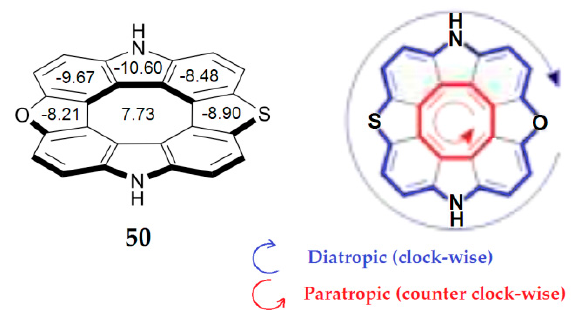
Figure 14. The structure of diazaoxathia[8]circulene. The NICS indices for 50 calculated in the center of each ring by the B3LYP/6-311++G(d,p) method in GIAO approximation [94].